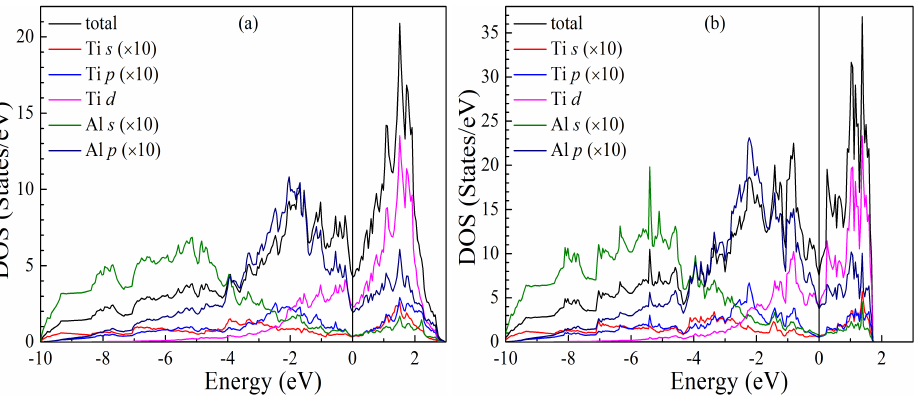
Figure 12. Calculated total and partial densities of states (DOSs) for the LPS ( a ) h- and ( b ) r-Al 2 Ti at 0 GPa and 0 K. The Fermi level is shift to 0